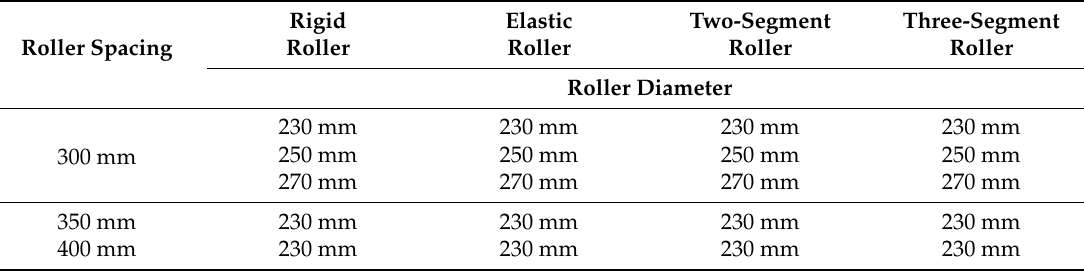
Table 5. Simulation parameters of bulging